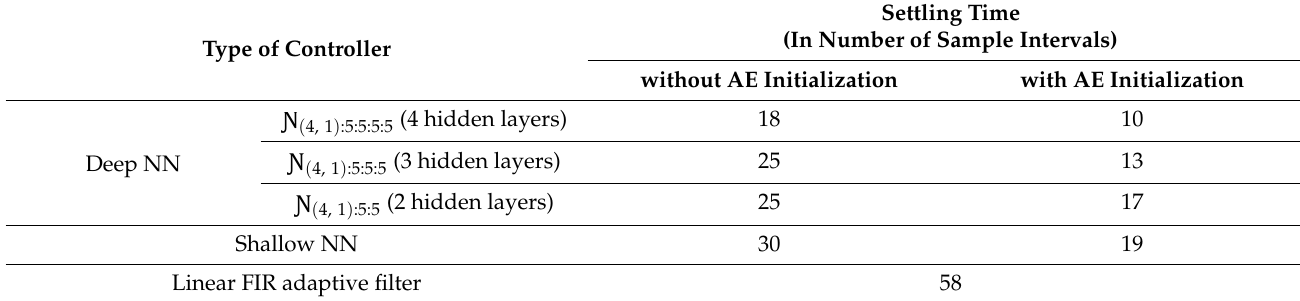
Table 1. Settling time after nonlinear-plant parameter change (Equation (7)) vs. number of deep NN hidden layers, and settling time when using a linear FIR adaptive filter. α = 0.02, α ae = 0.1, µ = 0. Settling Time (In Number of Sample Intervals) Type of Controller without AE Initialization with AE Initialization